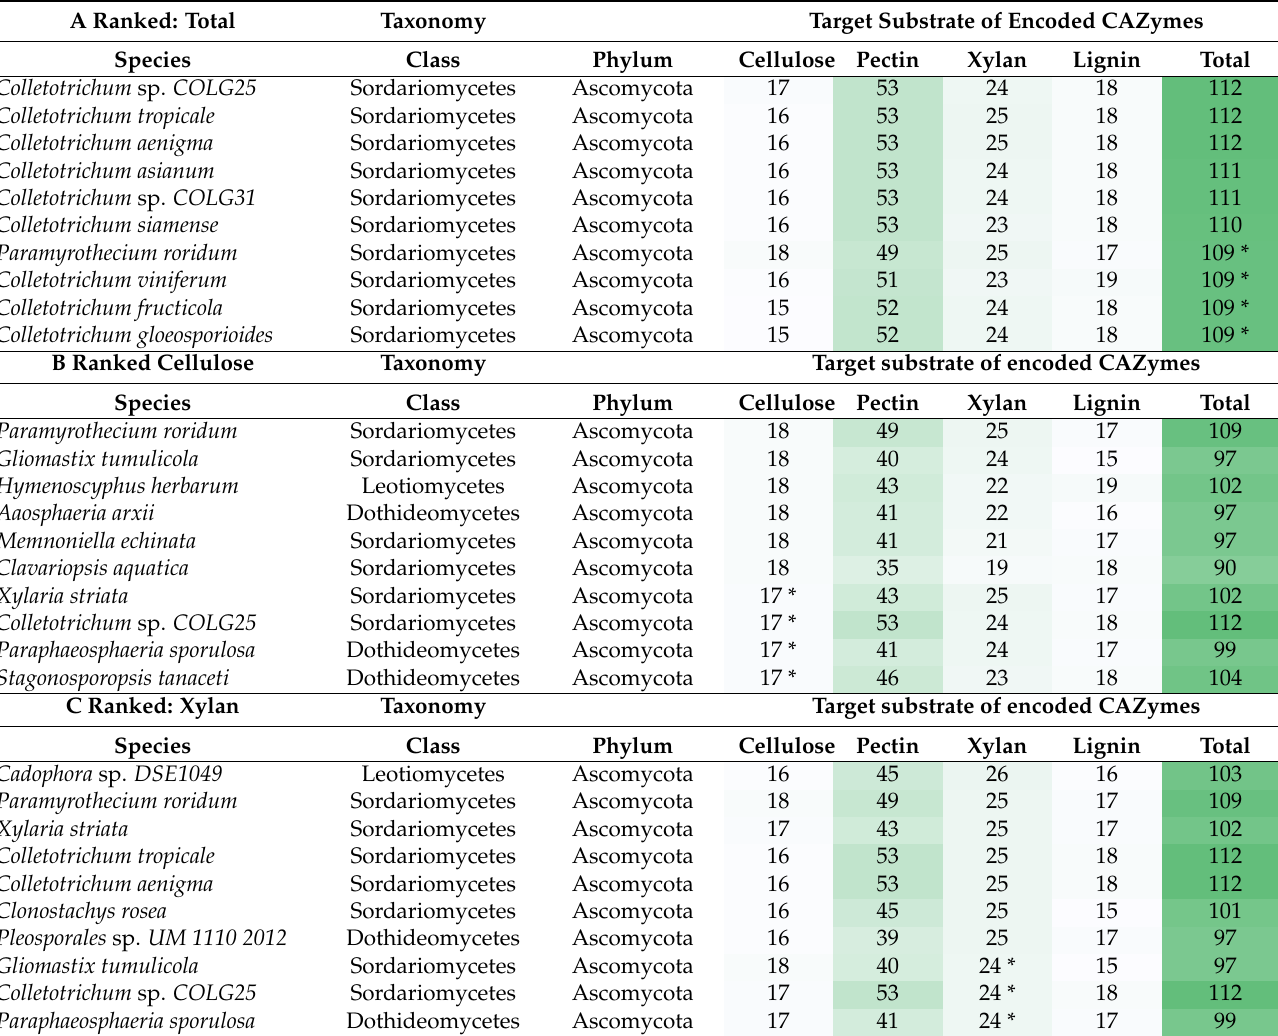
Table 2. Listing of the ten top-ranked species with regard to enzyme function specificity diversity (including only unique observations), specifying the number of “Function;Family” observations. The table includes ranking according to “Total” (A), followed by ranking according to enzyme observations with affinity for each of the target substrates, Cellulose (B), Xylan (C), Pectin (D) and lignin (E). (*) indicates more species with same number of observations. The total list of observations for the analyzed 1932 genomes is given in Table